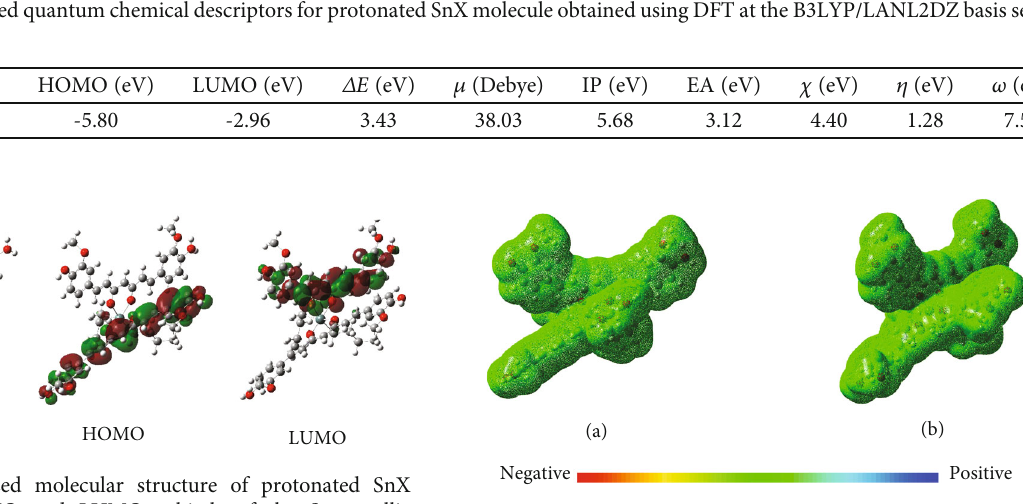
Figure 13: The calculated molecular electrostatic potential (MEP) map: the colour range (blue more positive, red more negative) oscillates for (a) neutral SnX, -1.041 e -1 from 1.041 e -1, and (b) protonated SnX, -9.952 from 9.952. Atomic colours represent gray (C), white (H), red (O), blue (N), and dark-blue-square